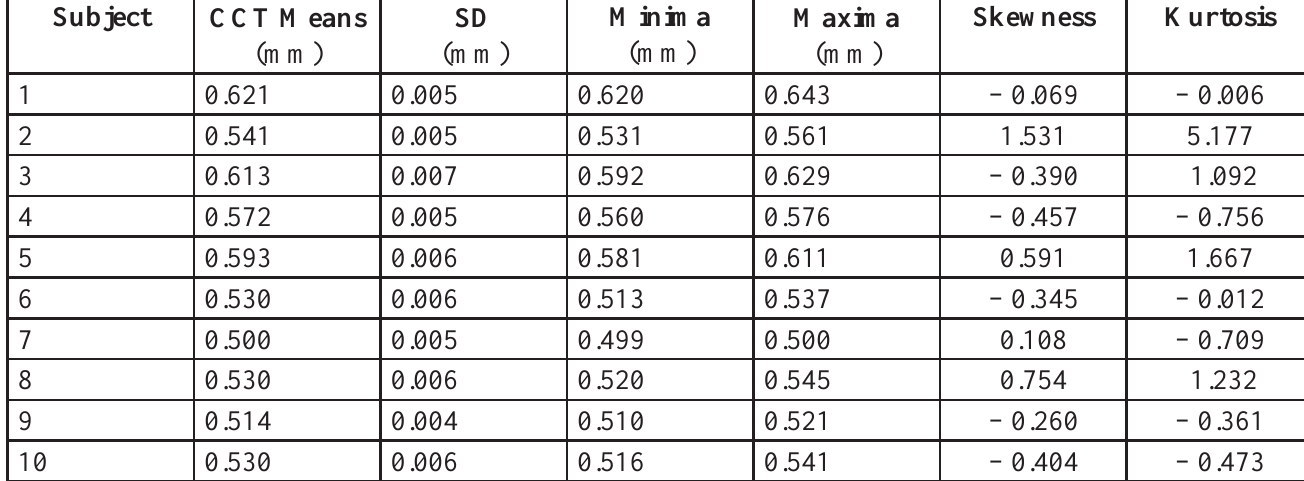
Table 1. Sample means, standard deviations (SD), maxima and minima for the central corneal thickness measurements (in mil- limeters) for the 10 subjects are indicated. If skewness is clearly different from zero then the distribution of measurements is asym- metrical and either positive or negative skewing is present as per the sign of the given value. If kurtosis is clearly different from zero the distribution displays leptokurtosis (and a positive value for the statistic is seen) or platykurtosis otherwise. Further information can also be obtained from histograms and normal probability plots such as in Figures 6 to 11.